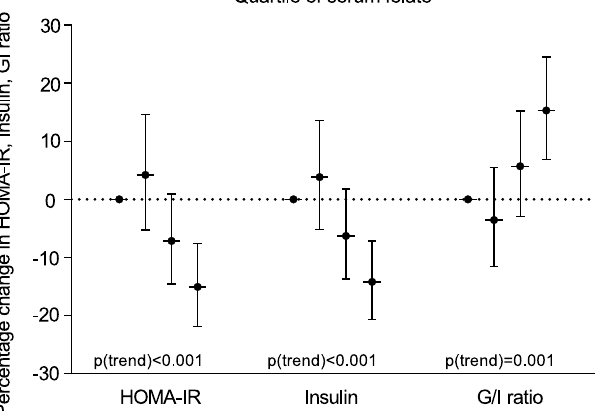
Figure 1. Adjusted percentage change in insulin resistance/sensitivity in relation to quartile of serum folate concentrations. Values are weighted for complex survey design and adjusted for sex, age,